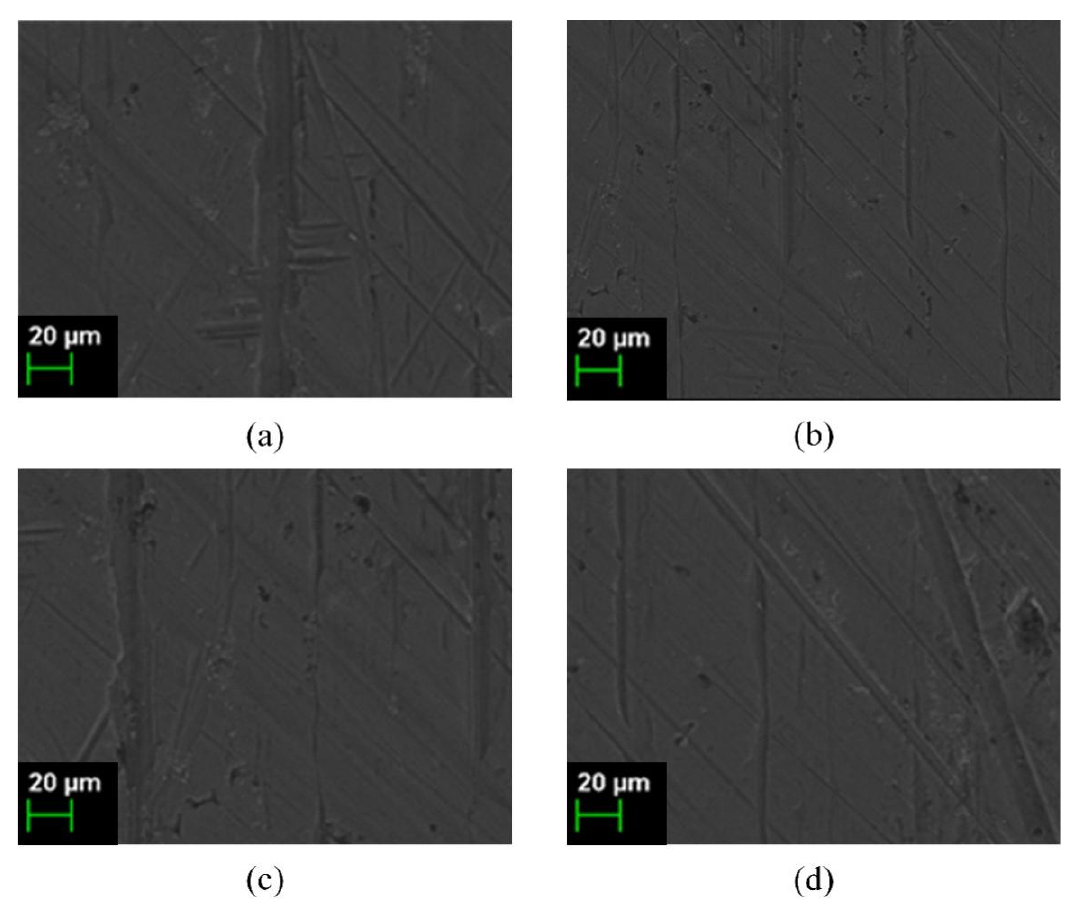
Figure 10. Wear surface at the speed of ( a ) original, ( b ) 800 rpm, ( c ) 900 rpm, and ( d ) 1000 rpm.